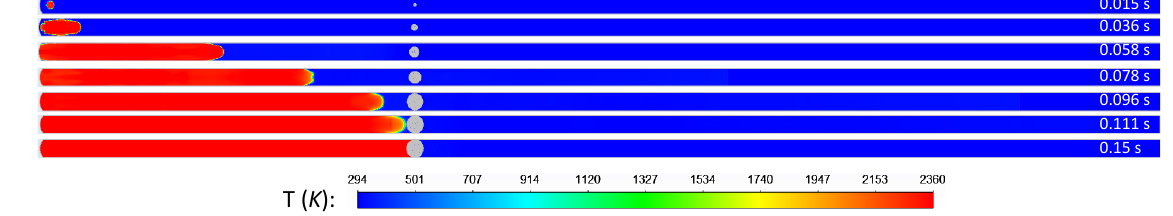
Figure 12. Flame propagation after explosion occurs for the scenario in which a single obstruction is installed and gradually inflated by 100% (full blockage) at x = 10 m.